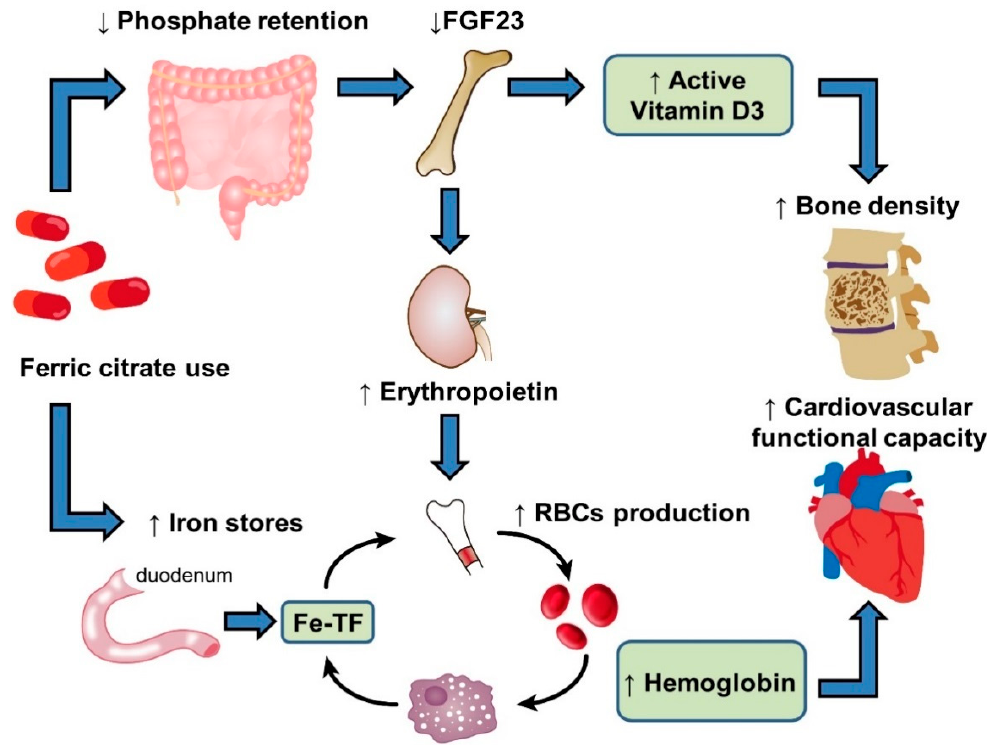
Figure 2. Illustration of the proposed mechanisms of action of ferric citrate (FC). FC binds dietary phosphorus in the gastrointestinal tract, thus controlling serum phosphate levels, which results in reduced fibroblast growth factor 23 (FGF23) production. The resulting reduction of FGF23 levels leads to increased 1,25-dihydroxyvitamin D levels, which subsequently improves bone mineral density. Blocking FGF23 activity also stimulates renal erythropoietin production. FC also enhances intestinal iron absorption and utilization, thereby activating red blood cell (RBC) production in bone marrow and improving hemoglobin (Hgb) levels and cardiac functional capacity. “ ↑ ” (means increase), “ ↓ ” (means de- crease).